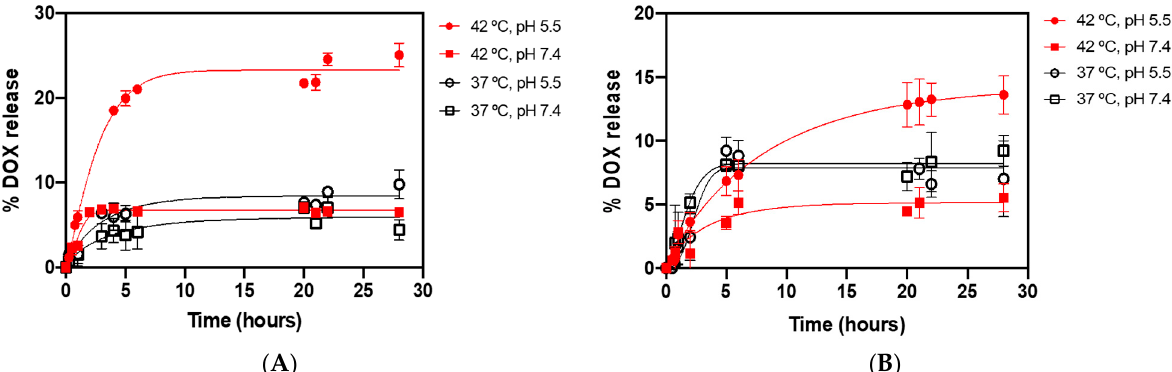
Figure 14. In vitro kinetic release profile of doxorubicin encapsulated in SMLs at different conditions of temperatures and pH, with the triplicate mean fitted to the Weibull kinetic model. ( A ) DPPC SMLs; ( B ) DPPC:DSPE-PEG SMLs.